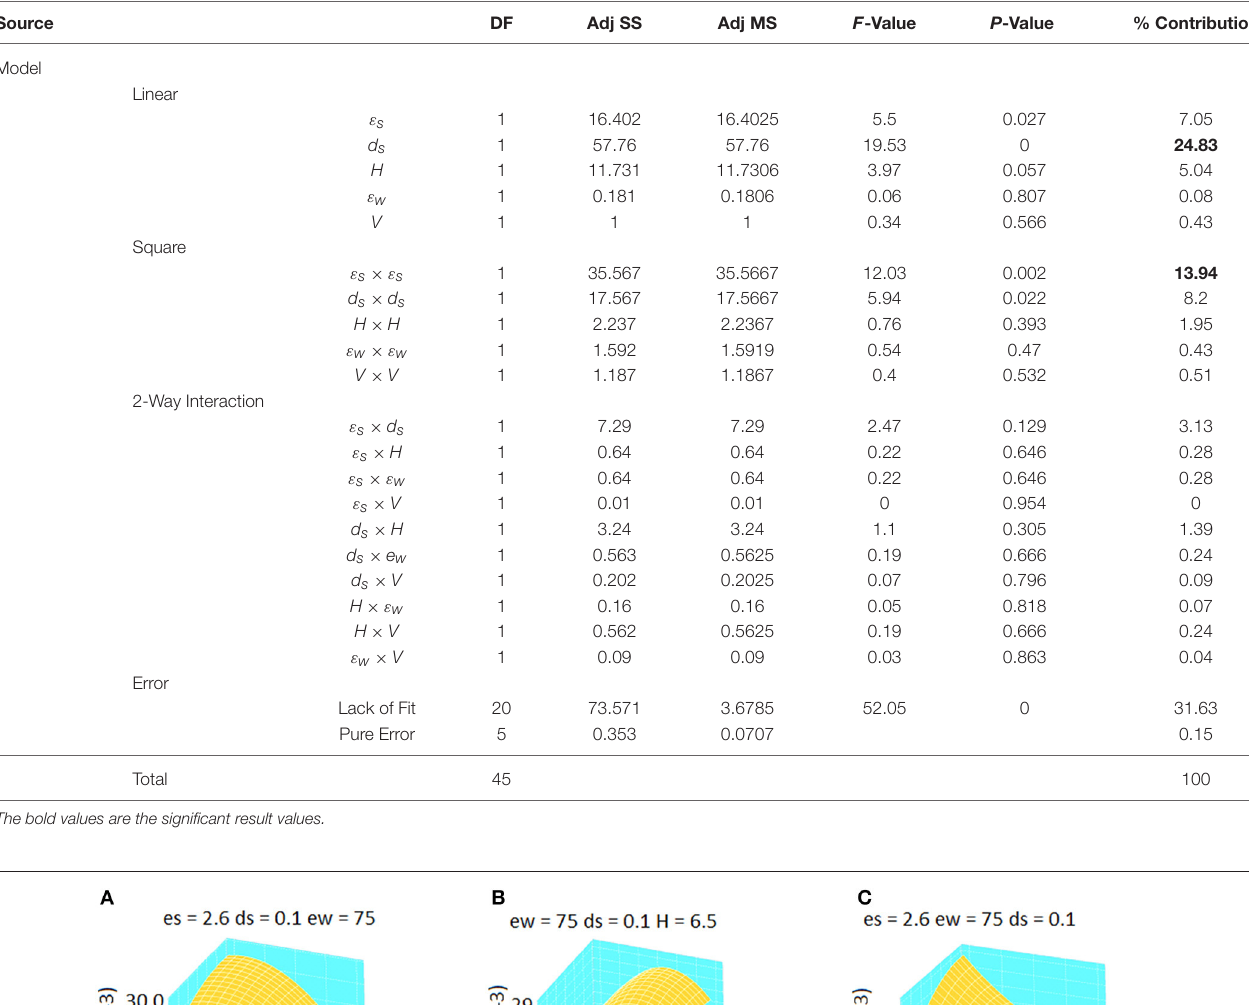
TABLE 4 | Results of the ANOVA for Zeta as the response variable. Source P -Value % Contribution Model